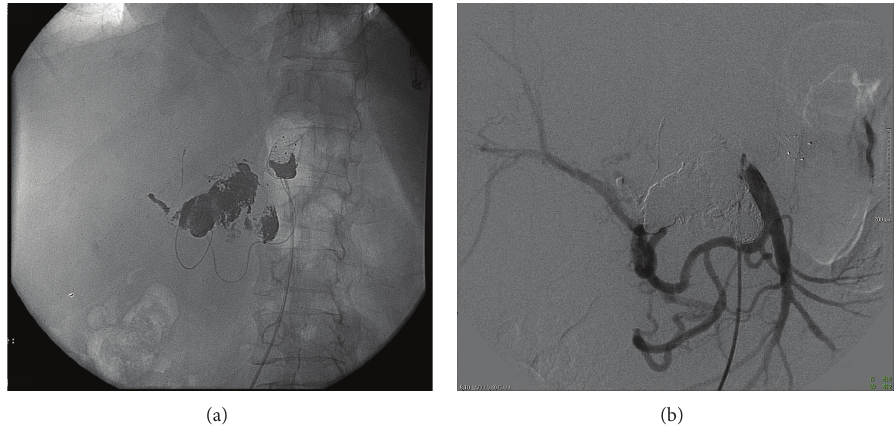
Figure 5: Diagnostic and procedural angiography. Approach from superior mesenteric artery catheterization. (a) Superselective micro- catheterization of the pancreaticoduodenal arcade to release Onyx and microcoils into the relapsed aneurysm sac; small fragments of Onyx are appreciable in the left hepatic artery because of involuntary migration; (b) final injection control showing complete exclusion of the lesion with preserved hepatic vascular